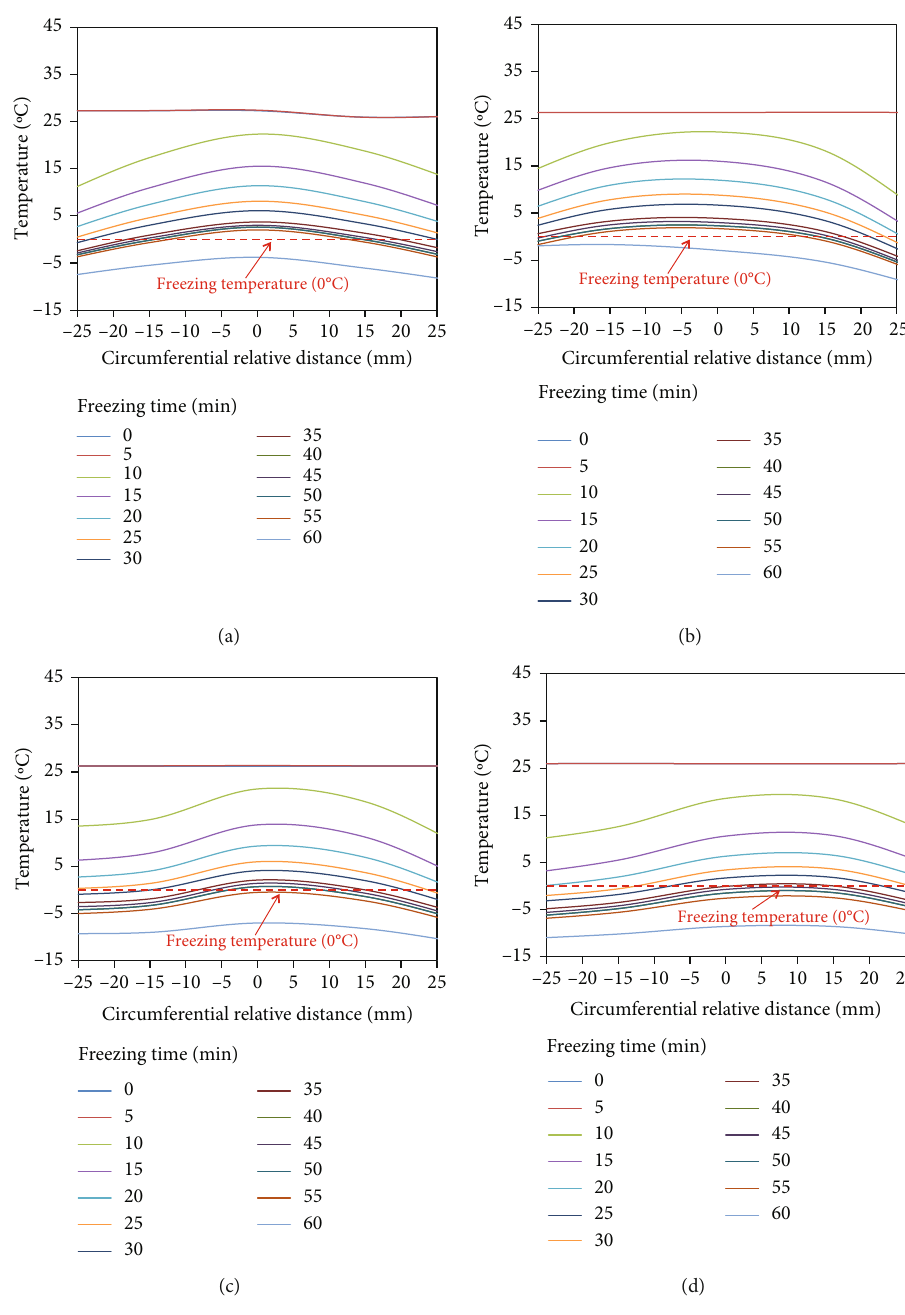
Figure 9: Circumferential temperature at the: (a) arch crown-J1, (b) arch baseline-J2, (c) wall corner-J3, and (d) base plate-